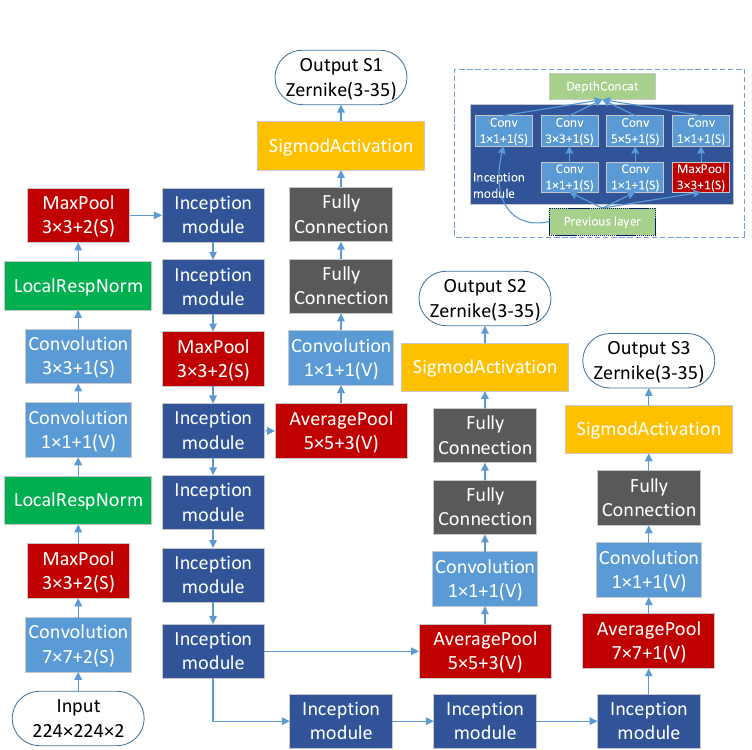
Figure 2. The architecture of GoogLeNet for turbulence aberration restoration. The structure of the Inception module in GoogLeNet is shown in the dotted box. When we use GoogLeNet to perform aberration restoration, the original input image is 224 × 224 × 2, where 2 refers to the normalized light intensity image in focus and out of focus, and the image is pre ‐ processed using the zero ‐ mean method (subtracting the mean from each pixel of the image). Finally, after the sigmoid activation, the Zernike coefficient of the distorted wavefront is obtained in our study, so a vector of length N is obtained.